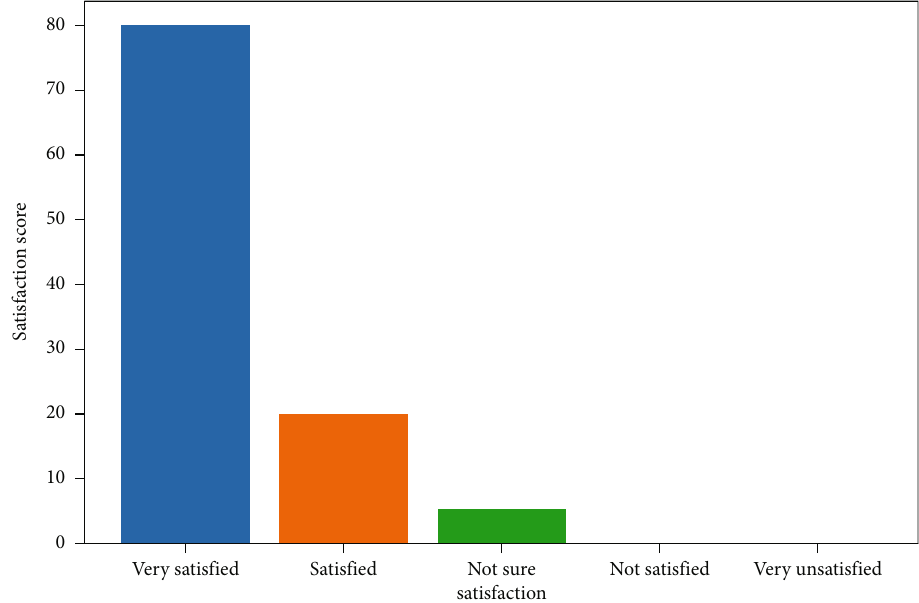
Figure 7: Teaching e ff ect evaluation of speech synthesis technology integrated into preschool children ’ s drama